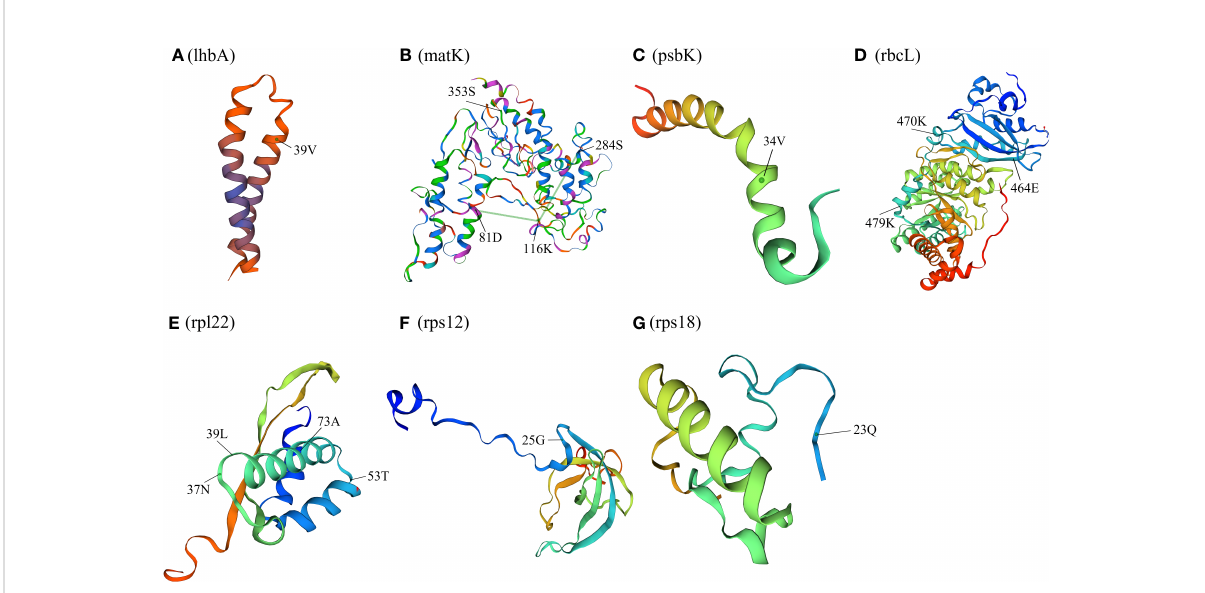
FIGURE 8 Spatial location of the positively selected sites in proteins of P. clavisepala. (A) Spatial location of the positively selected sites in the lhbA protein of P. clavisepala. A, B Spatial location of the positively selected sites in the matK protein of P. clavisepala. A, C Spatial location of the positively selected sites in the psbK protein of P. clavisepala. A, D Spatial location of the positively selected sites in the rbcL protein of P. clavisepala. A, E Spatial location of the positively selected sites in the rpl22 protein of P. clavisepala. A, F Spatial location of the positively selected sites in the rps12 protein of P. clavisepala. A, G Spatial location of the positively selected sites in the rps18 protein of P.